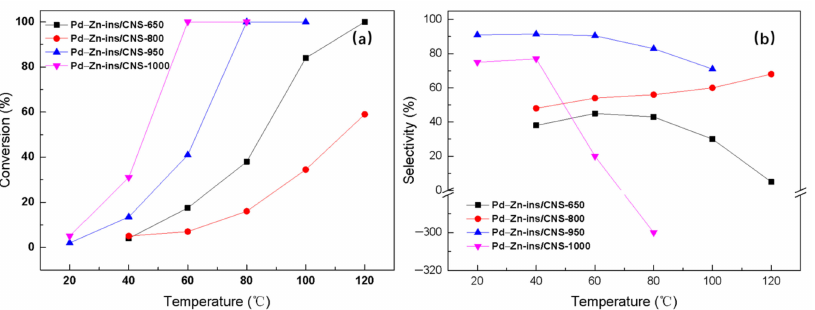
Figure 7. ( a ) Acetylene conversion and ( b ) ethylene selectivity over a serial of Pd–Zn-ins/CNS-X obtained at different carbonization